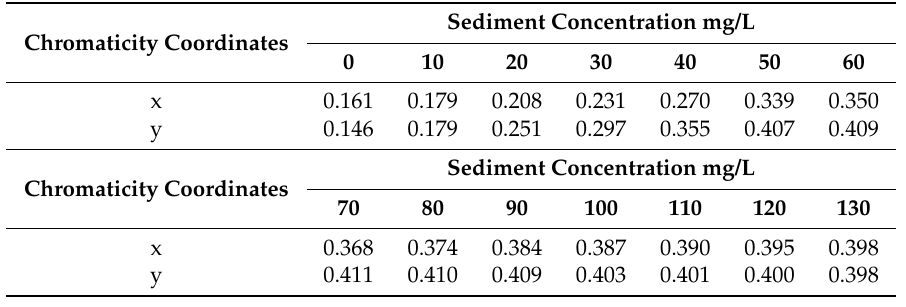
Table 5. Summary of chromatic coordinates prediction for a mountain lake with different sediment concentration